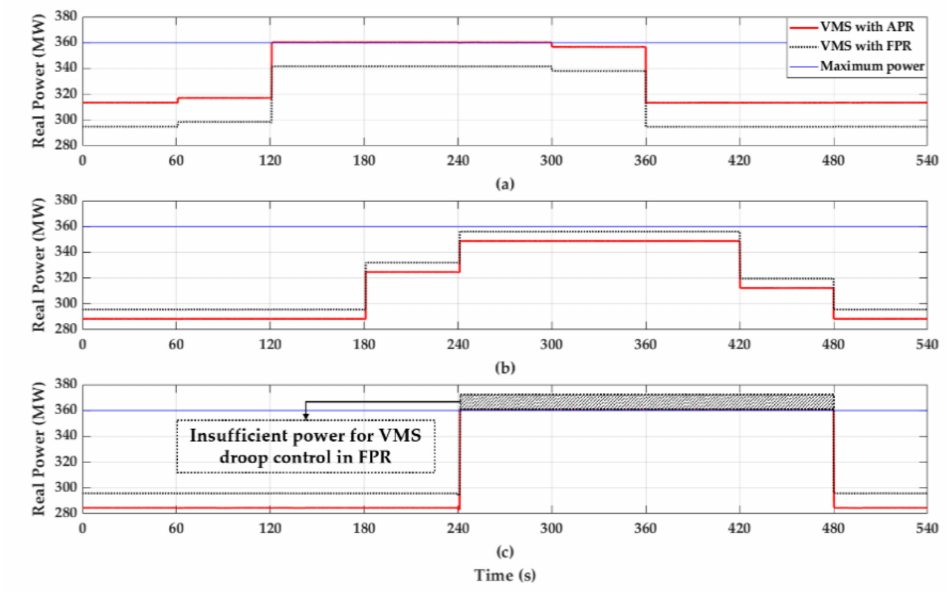
Figure 8. The comparison of output power of CBG according to its power reserve: ( a ) Area 1 ( b ) Area 2, and ( c ) Area 3. APR, appropriate power reserve; FPR, fixed power reserve.